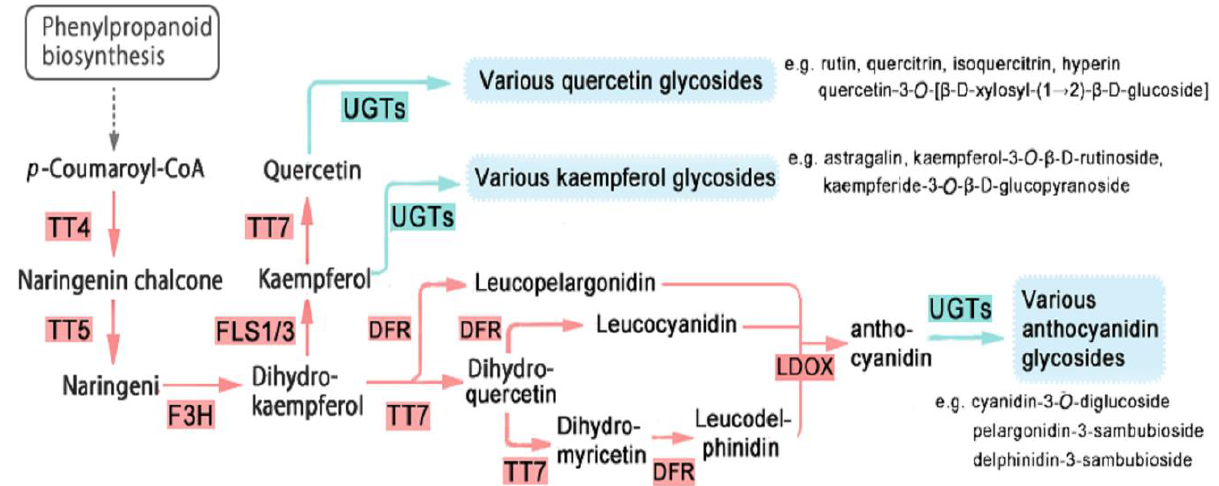
Figure 9. A proposal scheme of biosynthesis of flavonoids and their glycosides in E. ulmoides . BAN, NAD(P)-binding Rossmann-fold superfamily protein; DFR, dihydroflavonol reductase; FLS1, flavonol synthase/flavanone 3-hydroxylase; FLS3, flavonol synthase; TT4, flavonol synthase; TT5, chalcone-flavanone isomerase; TT7, cytochrome P450; F3H, naringenin,2-oxoglutarate 3-dioxygenase; LDOX, leucoanthocyanidin dioxygenase; and UGT75, anthocyanidin 5- O -glucosyltransferase; UGT, UDP-Glycosyltransferase.